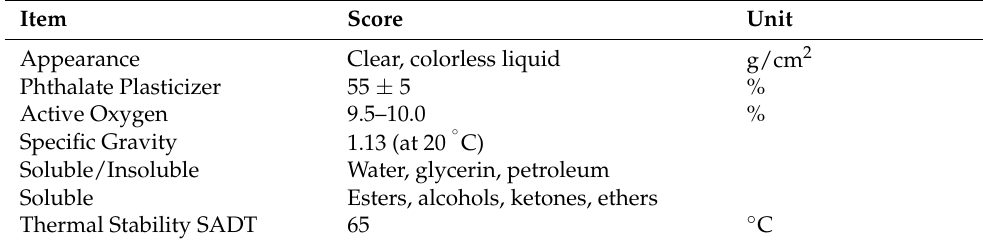
Table 2. Material properties of MEPOXE (methyl ethyl ketone